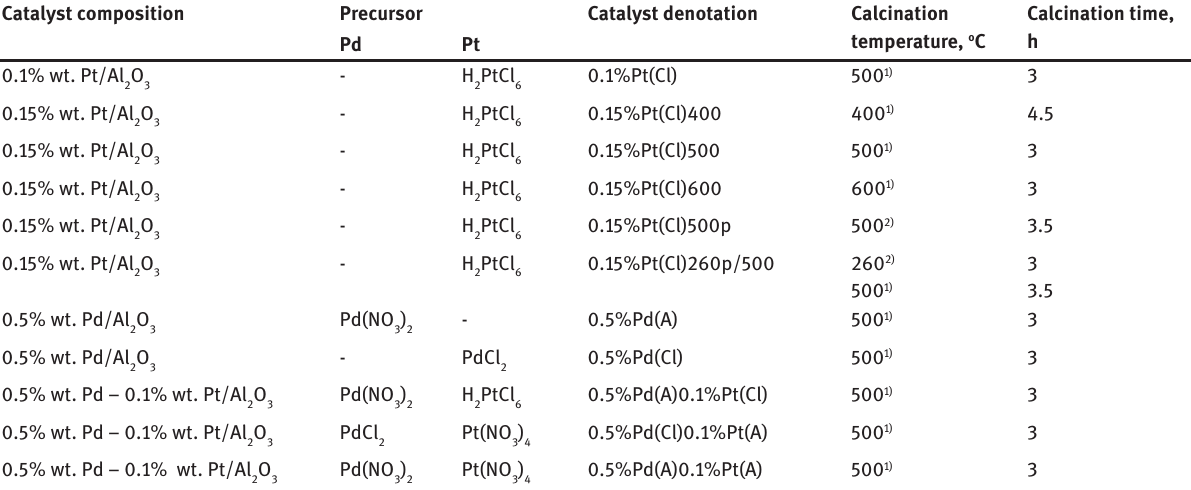
Table 1: Characterization of catalysts. Catalyst composition